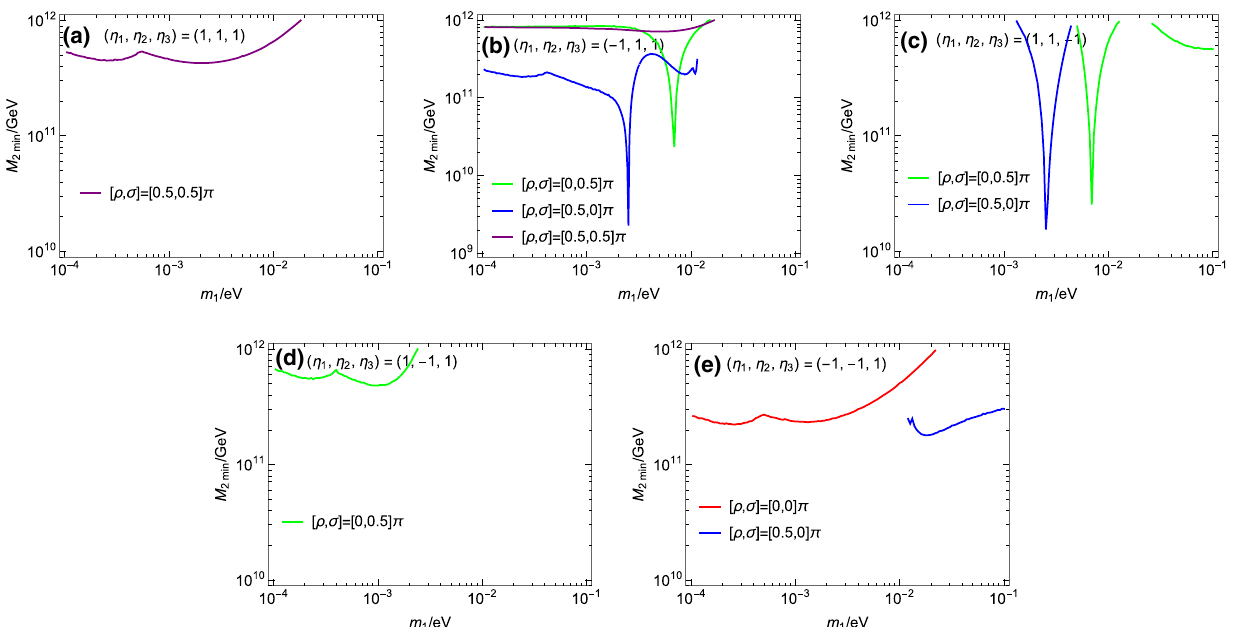
Fig. 8 In the scenario of M D respecting the μ - τ reflection symmetry, for the various combinations of (η 1 ,η 2 ,η 3 ) and [ ρ,σ ] , the lower bounds of M 2 as functions of m 1 in the NO case, imposed by requiring the Scenario I leptogenesis to be successful. These results are same for δ = π/ 2 and − π/ 2